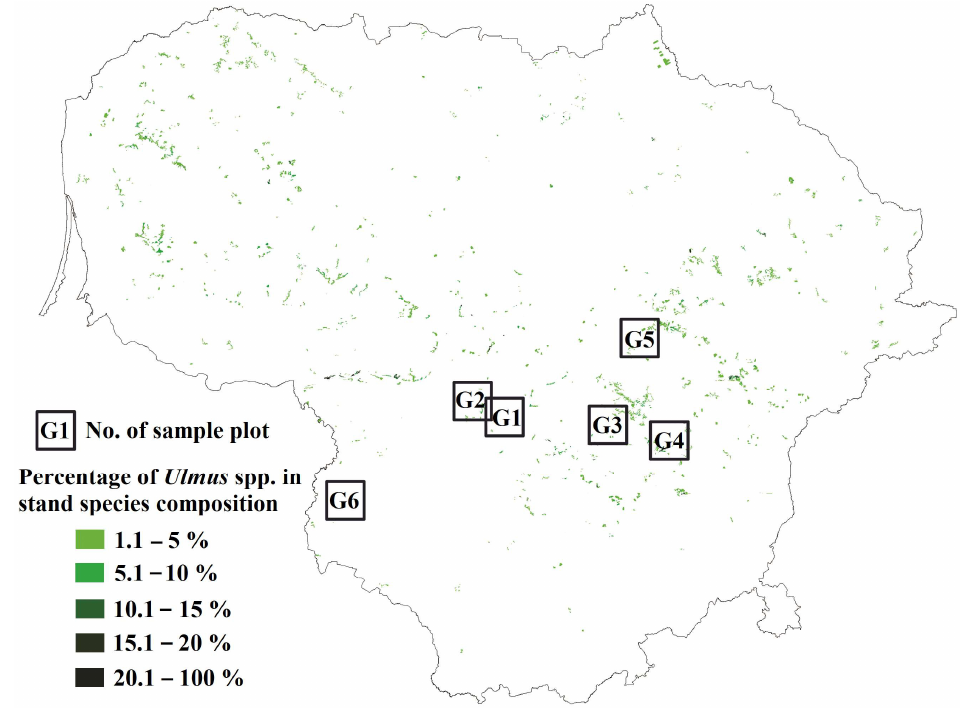
Figure 1. Map of Lithuania showing the distribution and composition of Ulmus spp. in stands (in green), where sampling of leaves and roots from healthy and diseased trees was carried out. Table 1. Characteristics of sample sites where roots and leaves from healthy-looking and diseased trees were sampled.